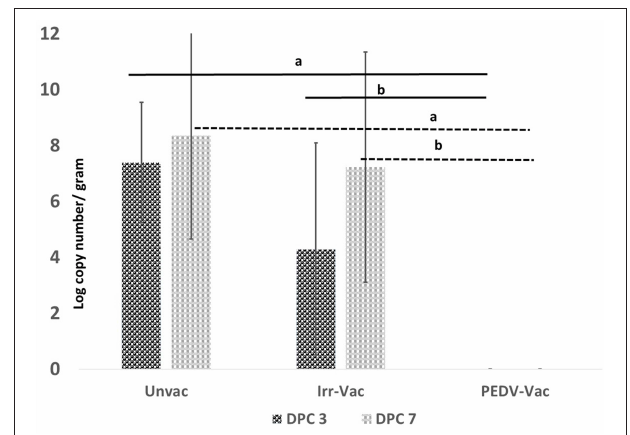
FIGURE 4 | Post-challenge fecal viral loads: Viral RNA detected by a PEDV-specific RT-qPCR on day 3 and day 7 post-challenge. X axis, experimental groups N = 6 pigs/group (2 pigs/group were sacrificed prior to challenge to assess vaccine safety); Y axis, mean of duplicate values of viral RNA copy number per gram of fecal matter; Dark bar, Day 3 post-challenge; Light bar, Day 7 post-challenge; a, Significantly different from the unvaccinated group; b, Significantly different from the other vaccine group. p < 0.05 by the Student’s T -test. Differences between the unvaccinated and irradiated vaccine group were not